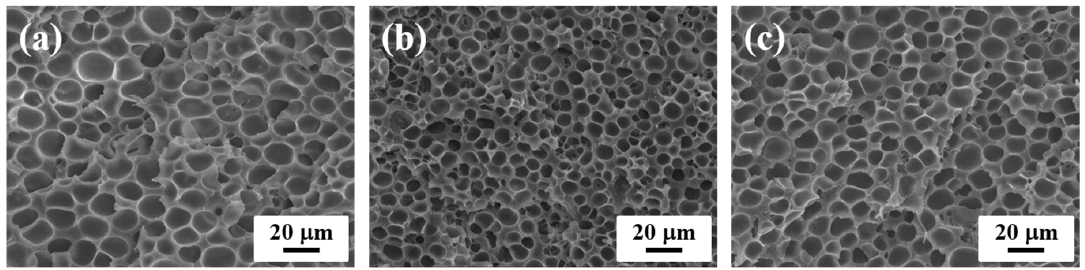
Figure 2. SEM micrographs of the cross-section of ( a ) cellulose nanofiber (CNF)-0, ( b ) CNF-0.2, and ( c ), CNF-0.4 foams at a fixed 2-fold expansion ratio.